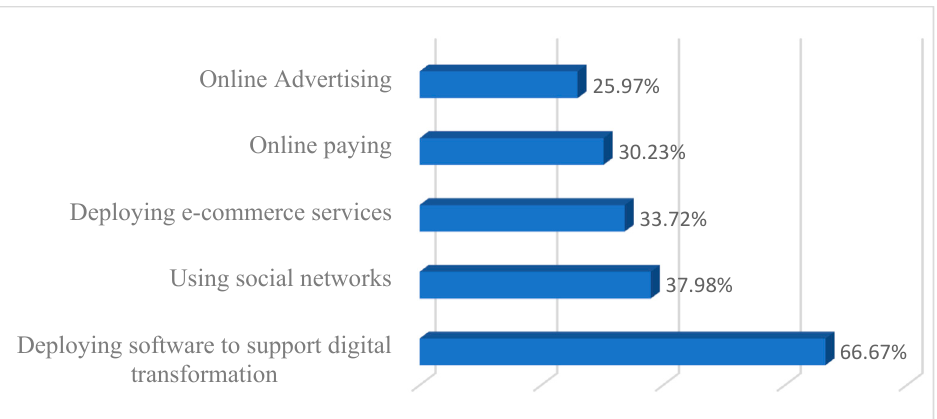
Figure 9. Services supporting digital transformation.